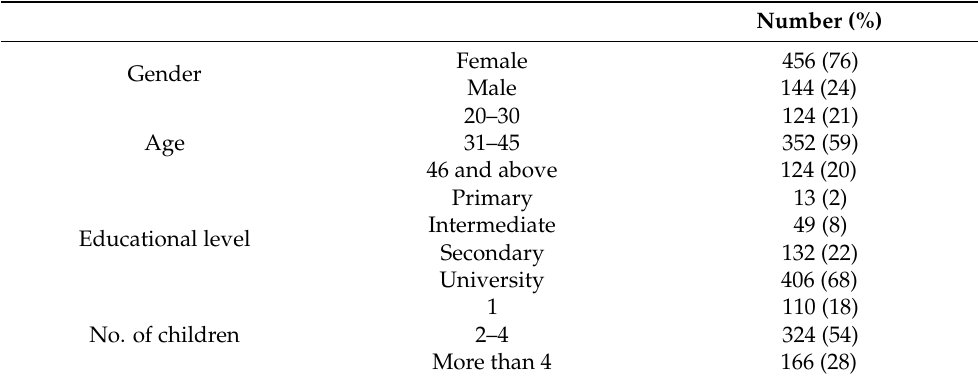
Table 1. Distribution of study participants according to sociodemographic variables.